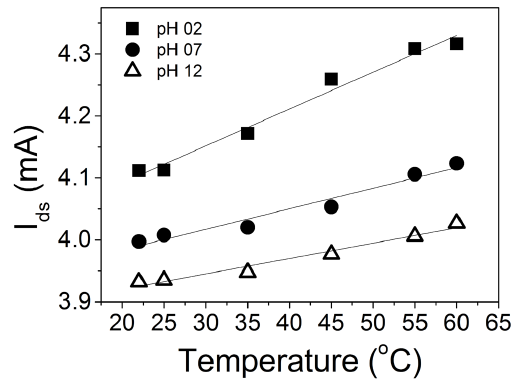
Fig. 5. Drain-source current as a function of operating temperature for three different pHs 2, 7 and 12.